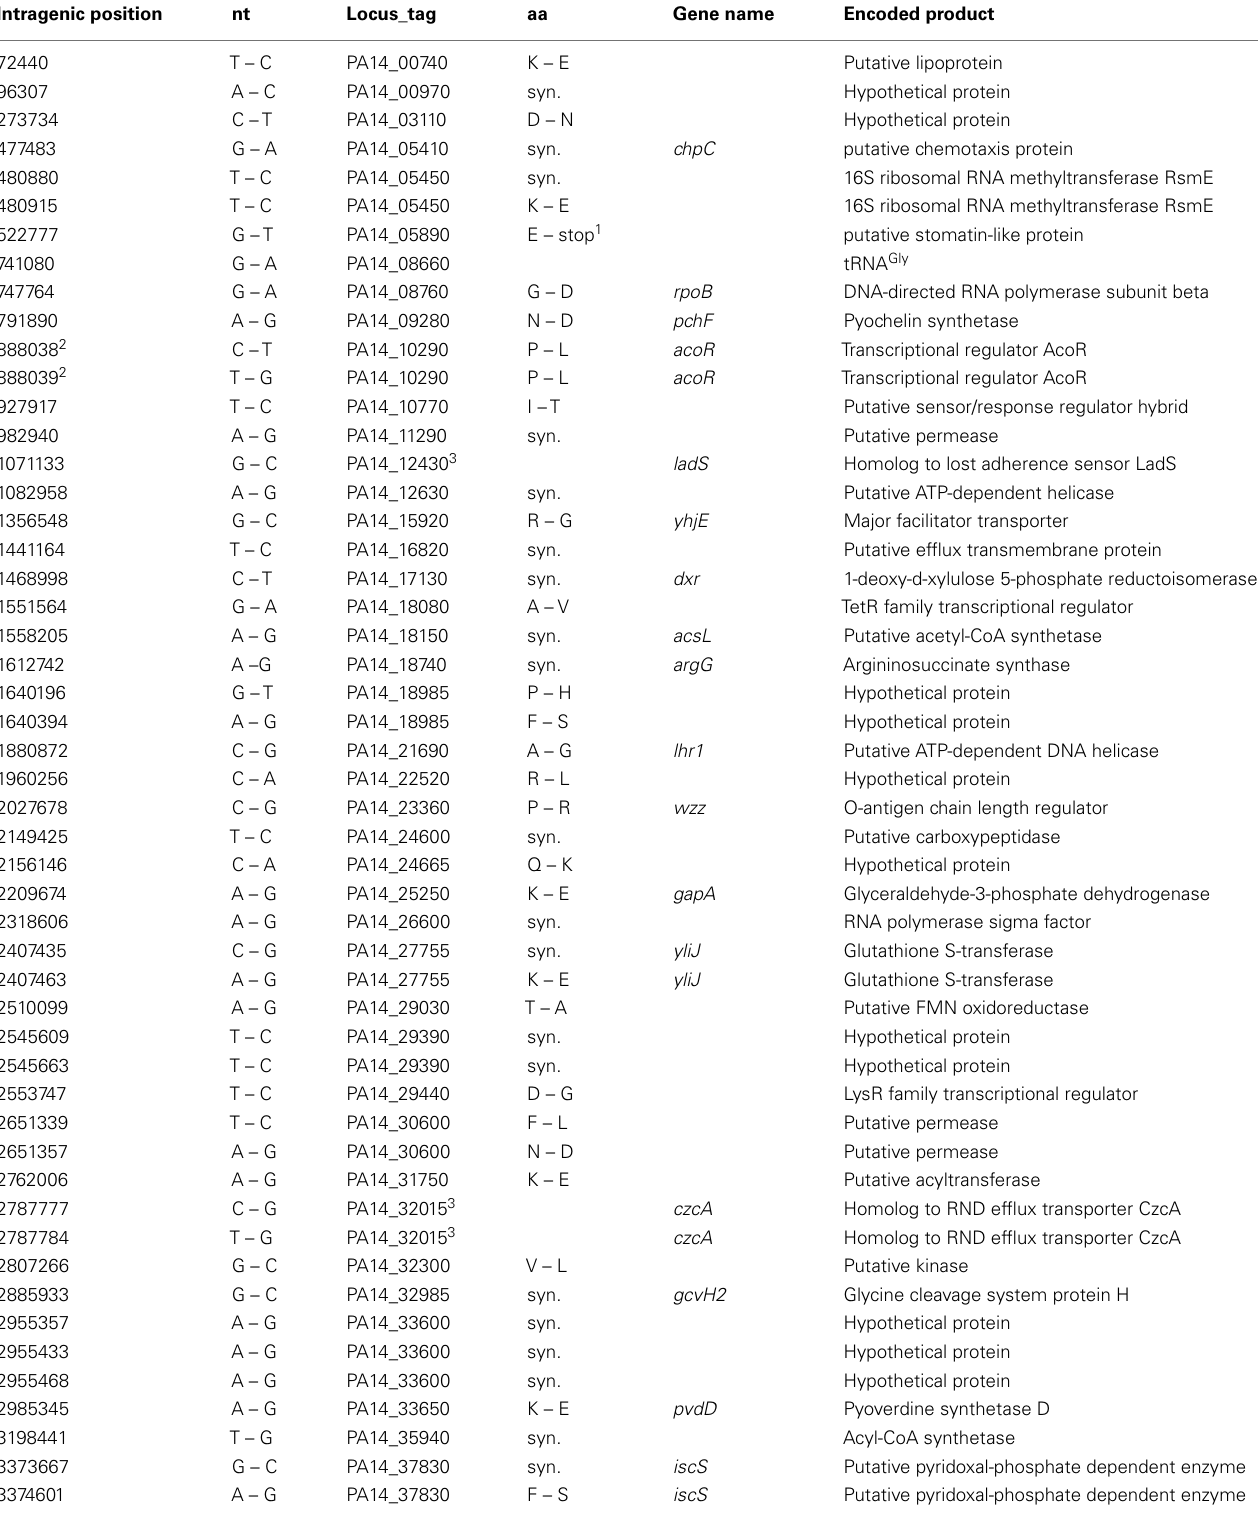
Table 4 | Single nucleotide substitutions in RN3 sequence (compared to PA14